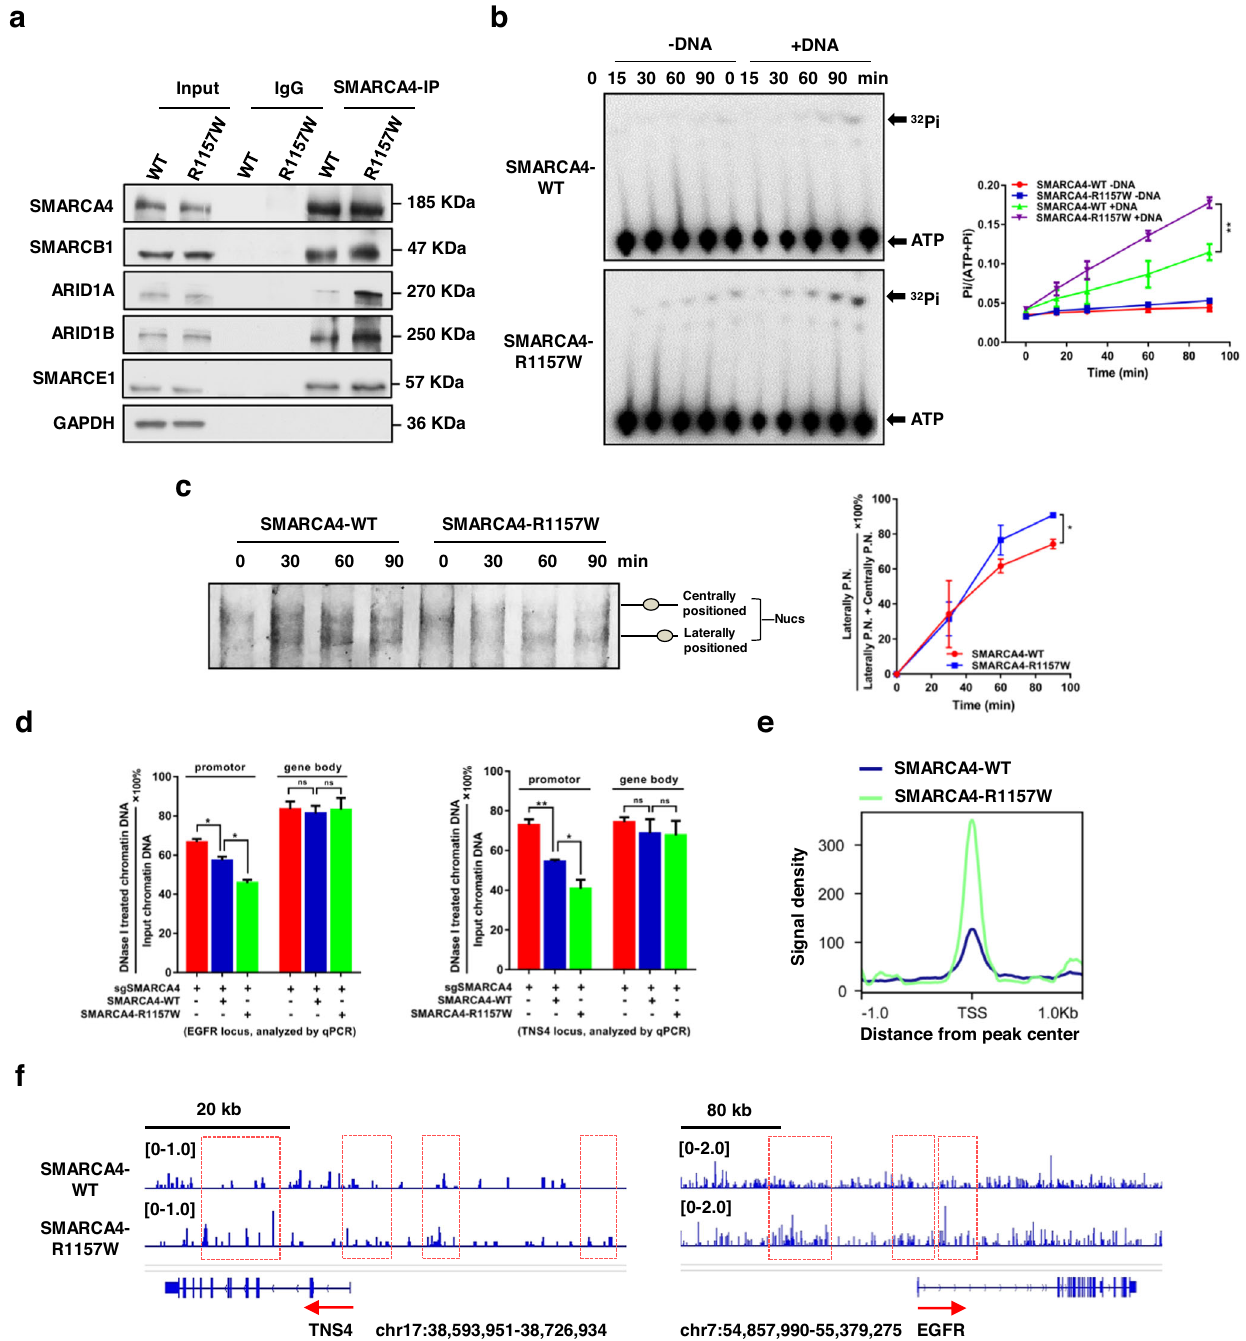
Fig. 4 The SMARCA4-R1157W mutation enhances ATPase activity and chromatin remodeling ability. a Coimmunoprecipitation assay with lysates prepared from HCT116 cells transfected with SMARCA4-WT or SMARCA4-R1157W plasmids. Anti-SMARCA4 antibody was used for the immunoprecipitation and lysates were immunoblotted for indicated proteins. b Time-dependent ATPase activity of SMARCA4-WT and SMARCA4-R1157W were assayed in vitro using γ - 32 P-labeled ATP combined with thin-layer chromatography (left panel). Quantitative analysis of the ATPase activity assay (right panel). ** P < 0.01. c Nucleosome sliding assay for establishing the remodeling activity of SMARCA4-WT and SMARCA4-R1157W at indicated time points (0, 30, 60, and 90 min) by native gel electrophoresis (left panel) for centrally positioned nucleosomes (P.N.) and laterally positioned nucleosomes. Quantitative analysis of the nucleosome repositioning (right panel). The vertical axis shows the percentage of [the amount of laterally P.N. DNA/(the amount of laterally P.N. DNA + the amount of centrally P.N. DNA)]. * P < 0.05. d DNase I chromatin accessibility assay was used to detect the effects of SMARCA4-WT and SMARCA4-R1157W on the accessibility of EGFR and TNS4 genomic regions. Primers were designed on the EGFR promoter region ( − 301 to − 132) and exon (4727 – 4823) to detect the accessibility of EGFR loci (left panel). Primers were designed on the TNS4 promoter region ( − 400 to − 228) and exon (2339 – 2491) to detect the accessibility of TNS4 loci (right panel). * P < 0.05, ** P < 0.01. e Metaplot of ATAC-seq signals around TSSs in SMARCA4-WT or SMARCA4-R1157W HCT116 cells within a ±1 kb window. f Genomic tracks of ATAC in the vicinity of the TNS4 and EGFR loci in SMARCA4-R1157W versus SMARCA4-WT HCT116 cells. Track height is normalized to the relative number of mapped reads. In the graphs, the error bars are the standard deviation of the